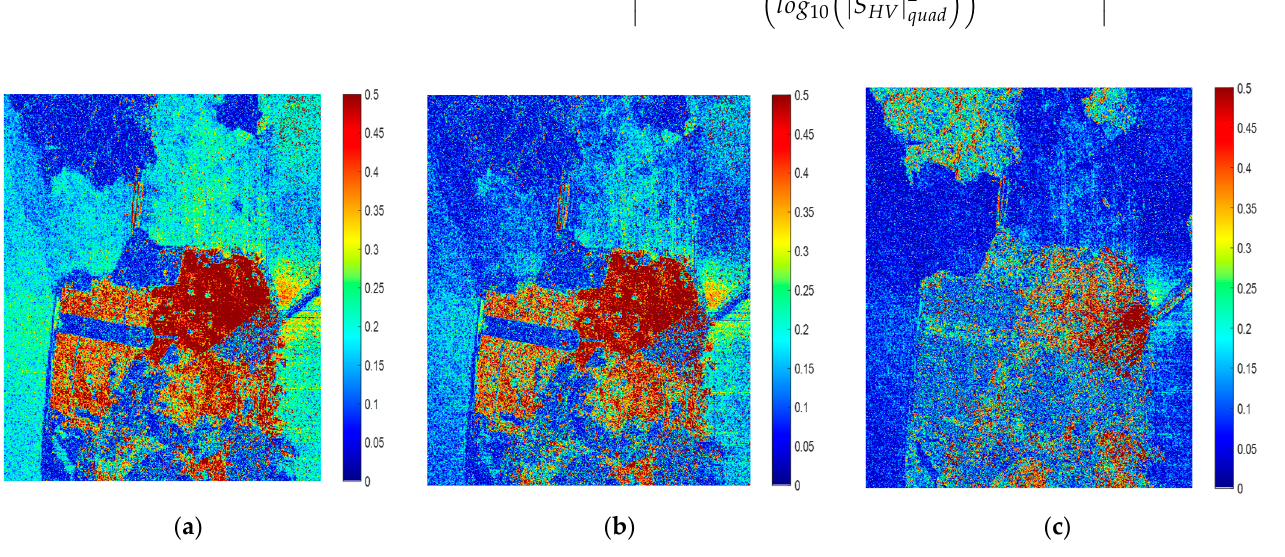
(cid:68) (cid:69) 2 S . ( a ) Souyris’ model. ( b ) Nord’s model. ( c ) Proposed | S HV | 2 . ( a ) Souyris’ model. ( b ) Nord’s model. ( c ) Proposed HV